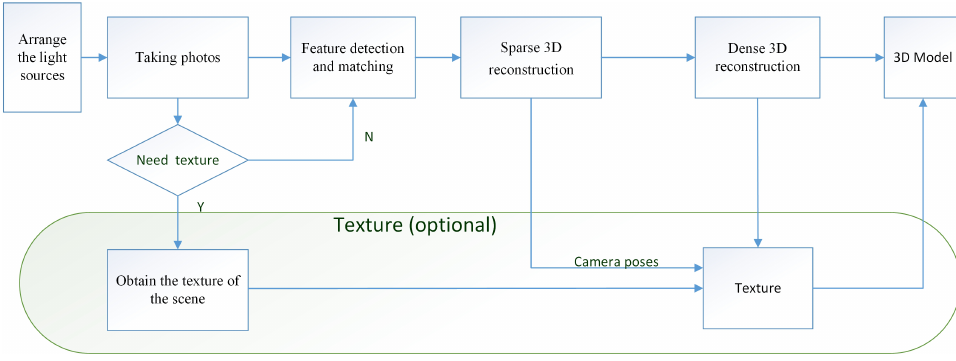
Figure 4. Reconstruction